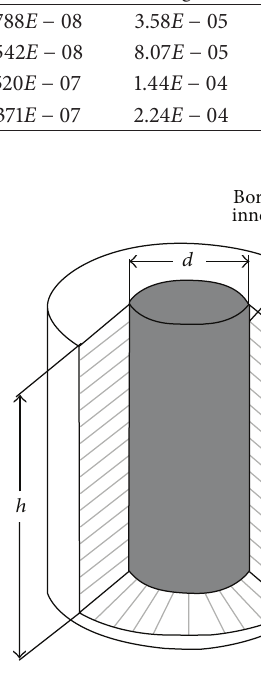
Figure 1: Schematic representation of the samples with the boron